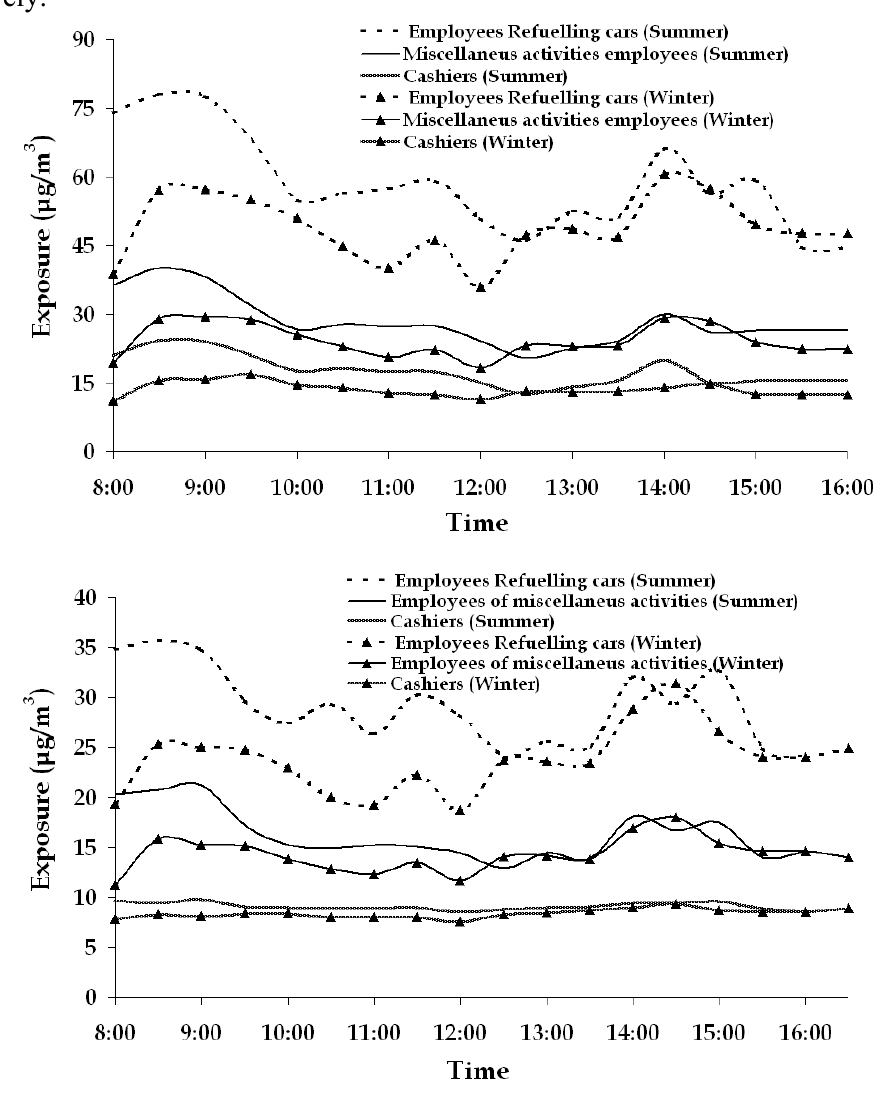
Figure 7 . Averaged weekly daily variation of the exposure (in μ g/m 3 ) for the three categories of employees in summer and winter of urban (a) and rural (b) filling stations